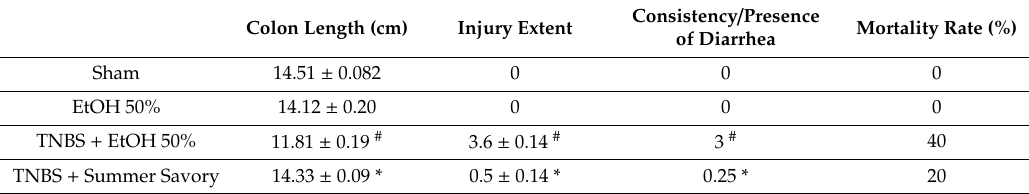
Table 4. Assessment of the colonic morphologic and functional characteristics.